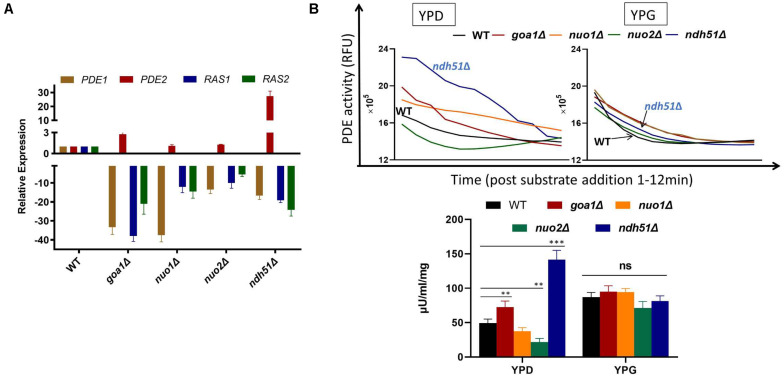
Validation of gene expression of two major G-proteins (RAS1/RAS2) and phosphodiesterases PDE1/PDE2 by RT-PCR (A) and cPDE activity (B) in four CI mutants. (A) The four genes’ expression profiles illuminate the cAMP patterns in the four CI mutants. The relatively normal cAMP levels found in two of the CI mutants (nuo1Δ and nuo2Δ) correlate with a smaller scale of downregulation in RAS1, RAS2, and PDE1 along with a normal PDE2 expression. A severe cAMP reduction in ndh51Δ results from a >25-fold increase in PDE2 expression while the other three genes are downregulated. A less than threefold increase in PDE2 expression in goa1Δ, together with a significant level of downregulation for PDE1, results in a moderate cAMP reduction in this mutant. (B) Variation of cAMP-phosphodiesterase (cPDE) activity in four CI mutants in YPD; ndh51Δ shows the greatest activity. cPDE activity (slope of RFU change within 12 min after substrate addition) example shown in the top panel. An increased cPDE activity is shown for the mutants in YPD, but not in YPG. The bottom panel represents the cPDE activity from three experiments normalized to μU/ml/mg protein. A threefold higher cPDE activity is shown in ndh51Δ with PDE2 upregulation and a 1.5-fold higher activity in goa1Δ versus WT. p values <0.001 are denoted as “***” and <0.01 as “**”.